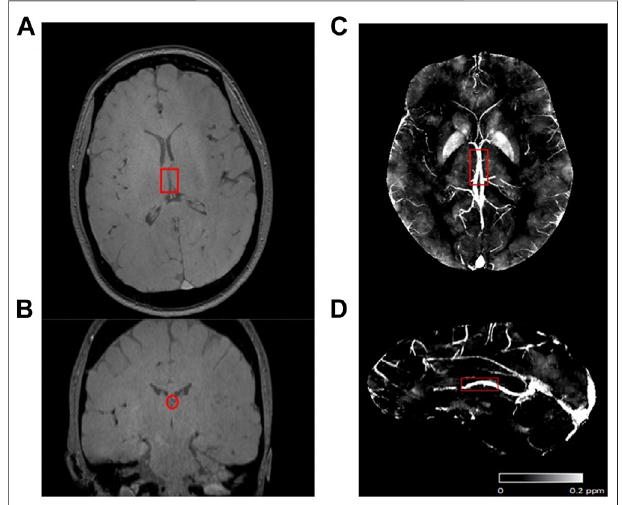
FIGURE1| Representativeimageandregionoftheinternalcerebralvein (ICV, highlight by red rectangle). (A) Magnitude in axial view. (B) Magnitude in coronal view. (C) Axial view, and (D) Sagittal view of ROI in the max intensity projection of a representative susceptibility